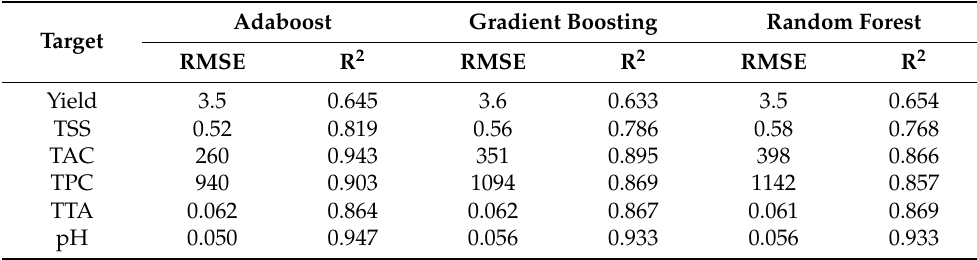
Table 4. The most accurate machine learning models to predict the target